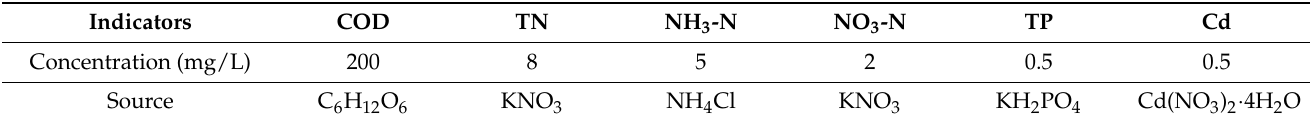
Table 1. Simulated raw water index